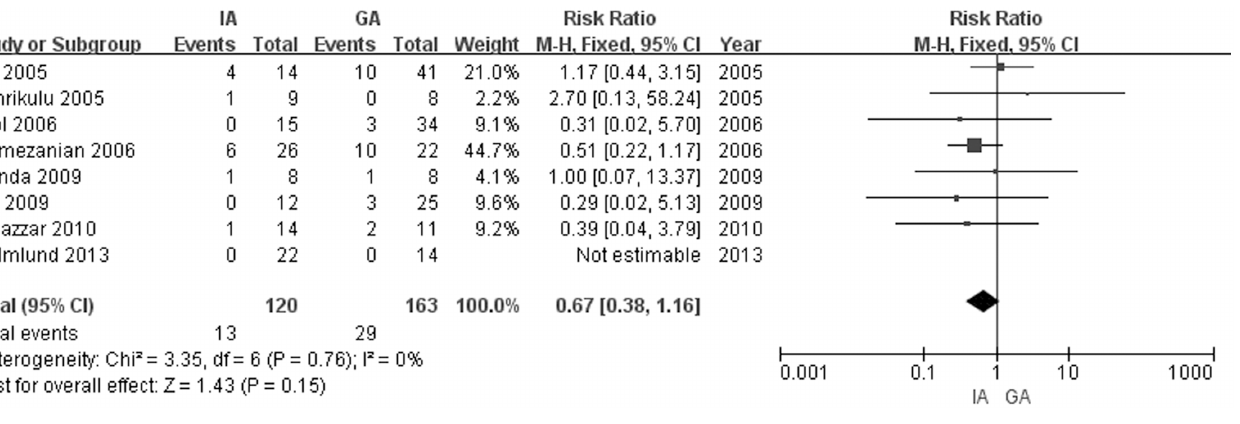
Fig 2. Forest plot of the occurrences of reankylosis (GA vs. IA).